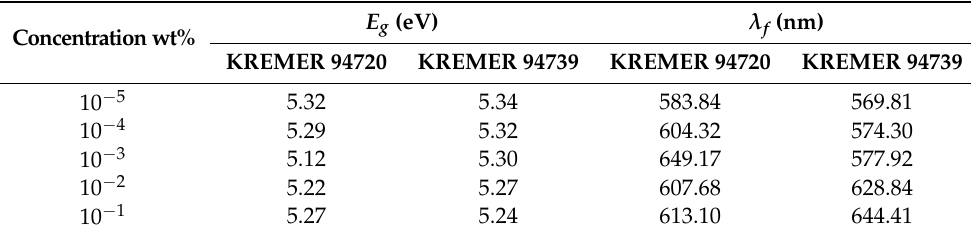
Figure 6. Correlation between the fluorescence spectra and inter-band transitions for photoselective PMMA greenhouse films doped with 0.1 wt% perylene dyes. Table 2. Correlation between the optical bandgap E g and the fluorescence peak λ f for photoselective PMMA greenhouse films.